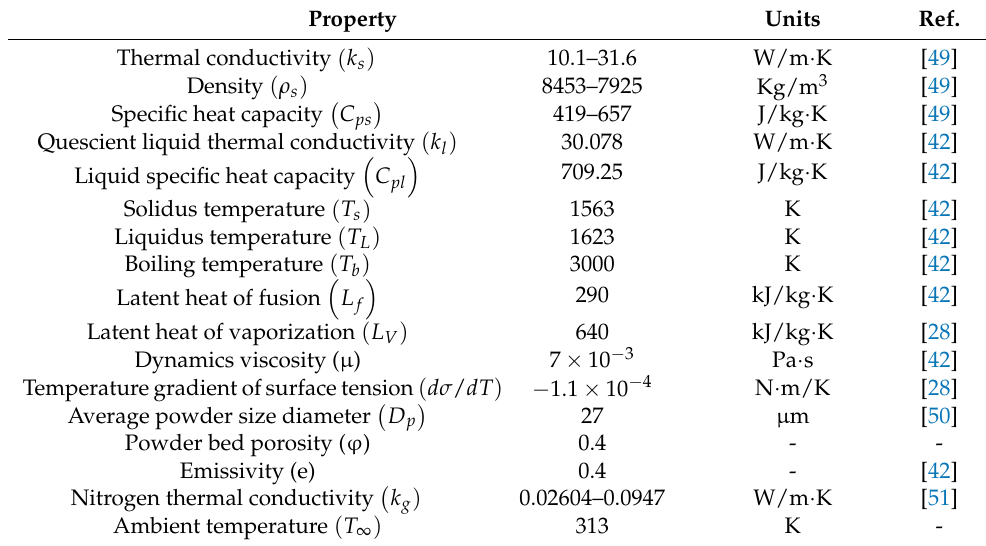
Table 1. Thermo-physical properties of